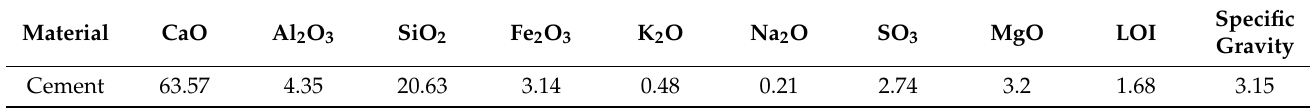
Table 1. Chemical compositions and physical properties of cement.